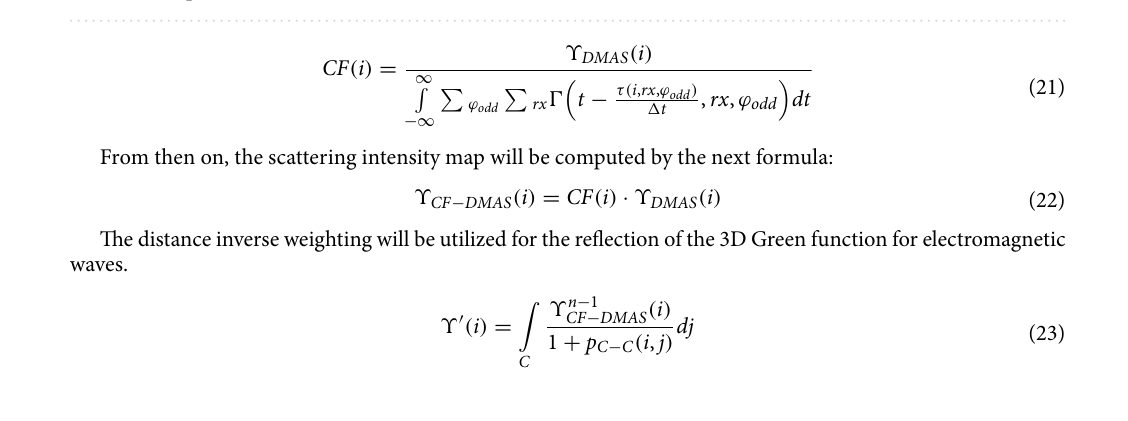
Figure 23. The proposed portable head imaging system ( a ) simulation model, and ( b ) perspective view with human head